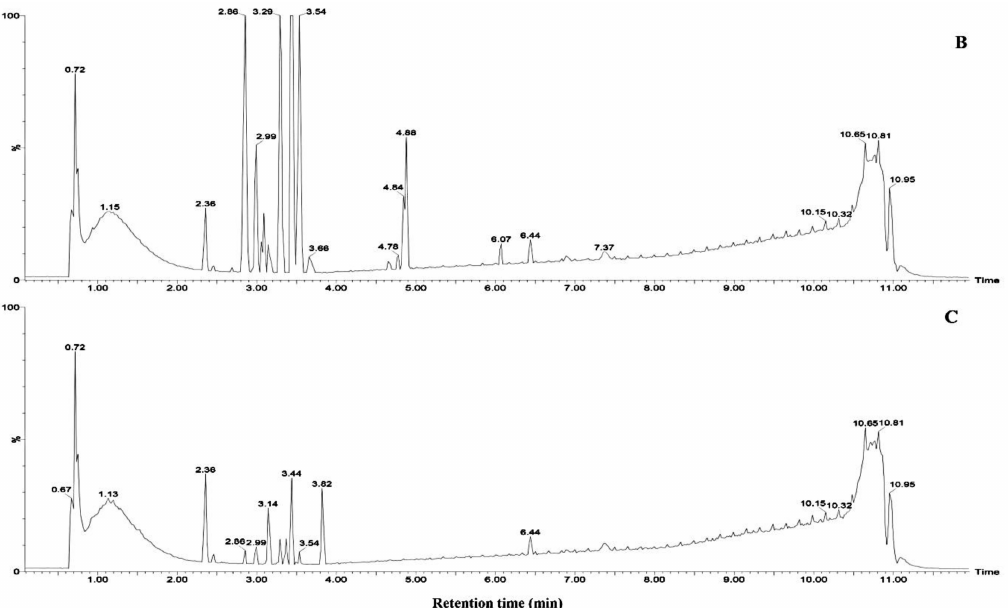
Figure 7. Identification of chemical constituents from K. candel leaf aqueous extracts in negative mode. ( A ) Young leaf, ( B ) Mature leaf, ( C ) Senescent leaf. Numbers above peaks represent retention times, in minutes.